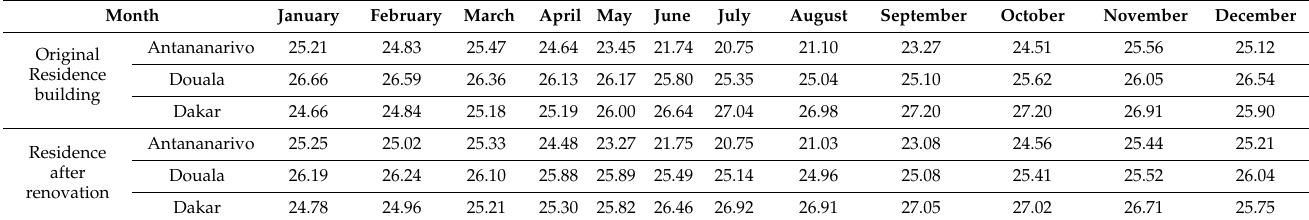
Table 6. Variation of indoor air temperature in tropical regions.